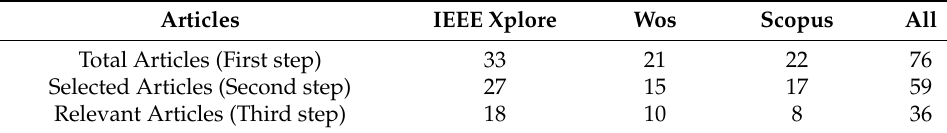
Table 1. Number of articles used in this